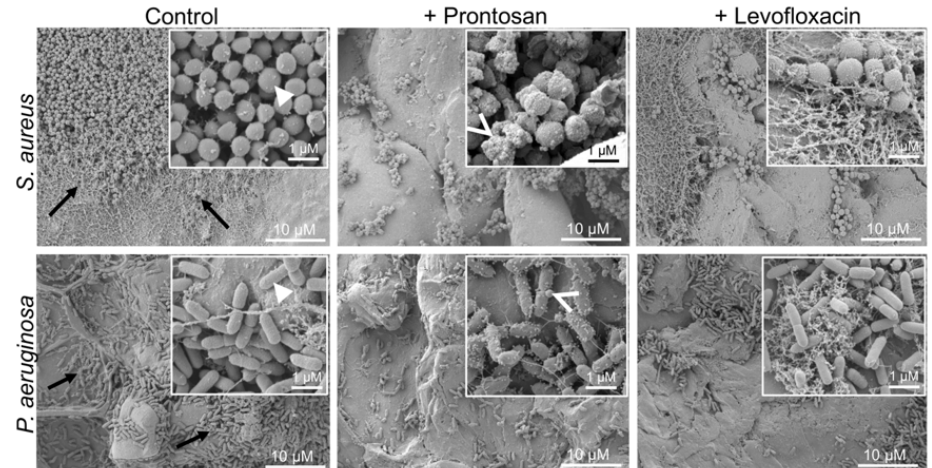
Figure 5. Scanning electron microscopy of surface of infected ex vivo wounds. Wounds were in- fected for 2 h with either S. aureus or P. aeruginosa . Infected wounds were then treated topically with Prontosan or 2 µg/mL Levofloxacin for 2 h. Biofilm formation and microcolonies are ob- served in the control wounds (arrow). Bacteria in control wound show smooth cell wall surface (arrowhead), and small perturbations (open arrow) were observed on bacterial surfaces in the Pronstosan